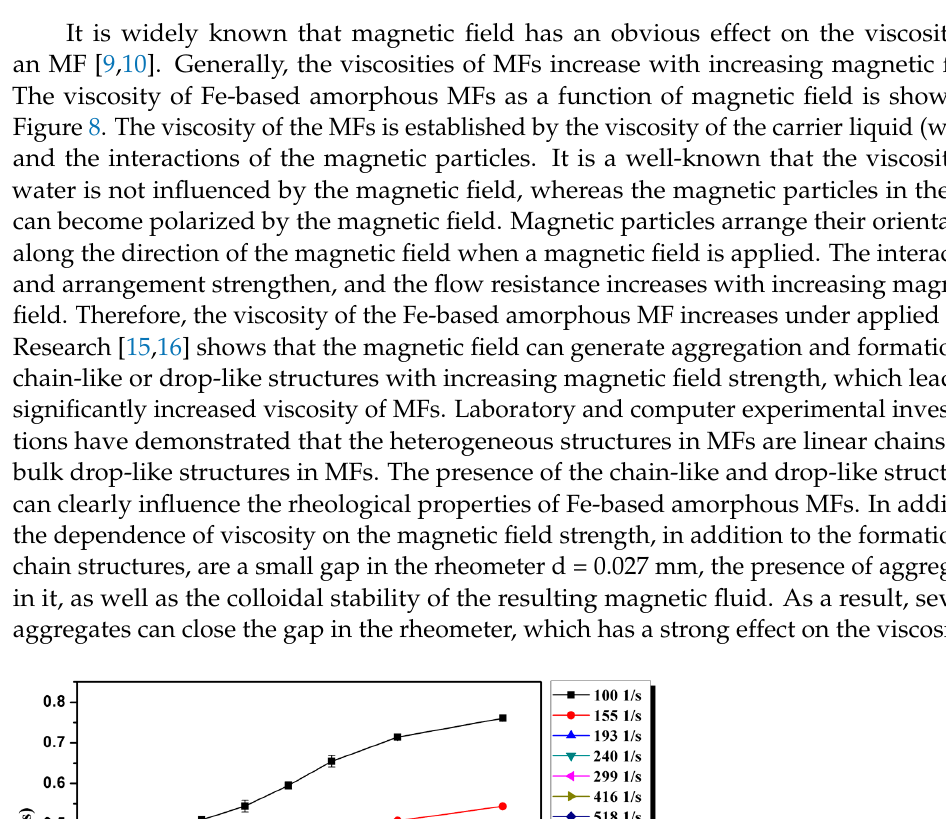
Figure 7. The yield stress of the amorphous MF as a function of magnetic field.